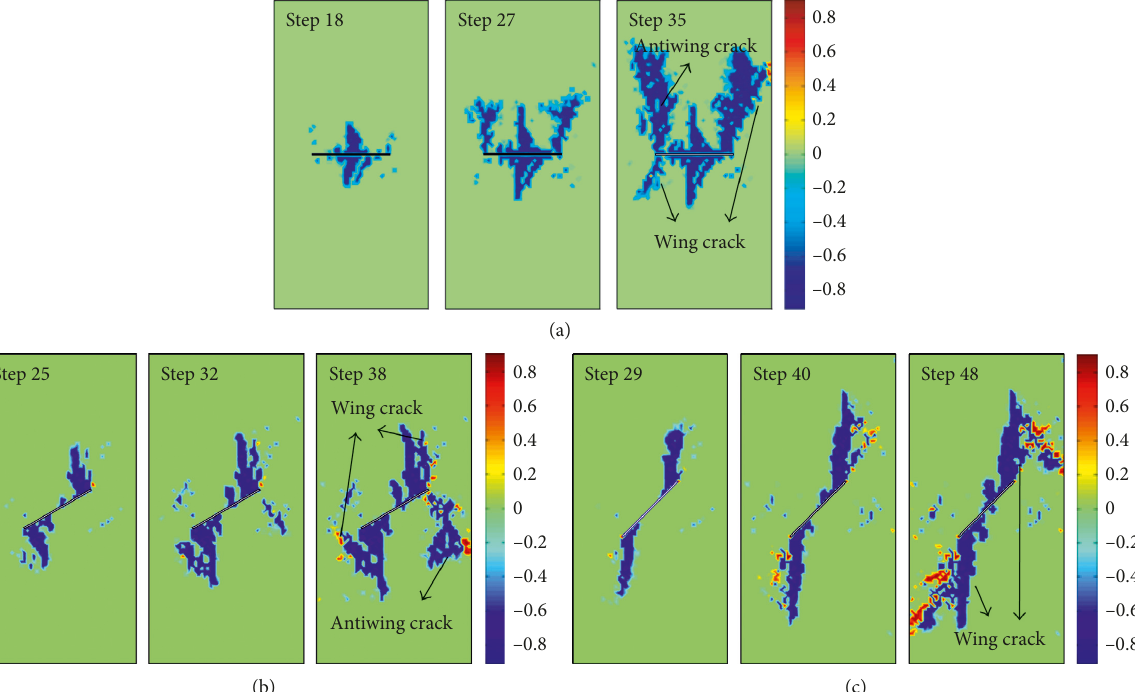
Figure 9: The stress-strain curves of uniaxial compression tests with different angles of preexisting